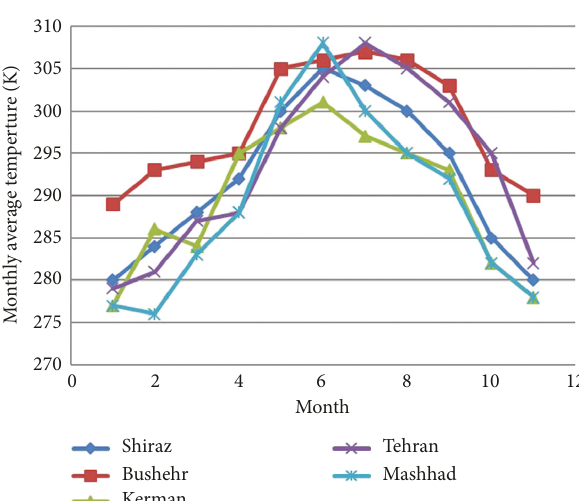
Figure 6: Average monthly total solar radiation per day in different months of the Gregorian year in selected cities.